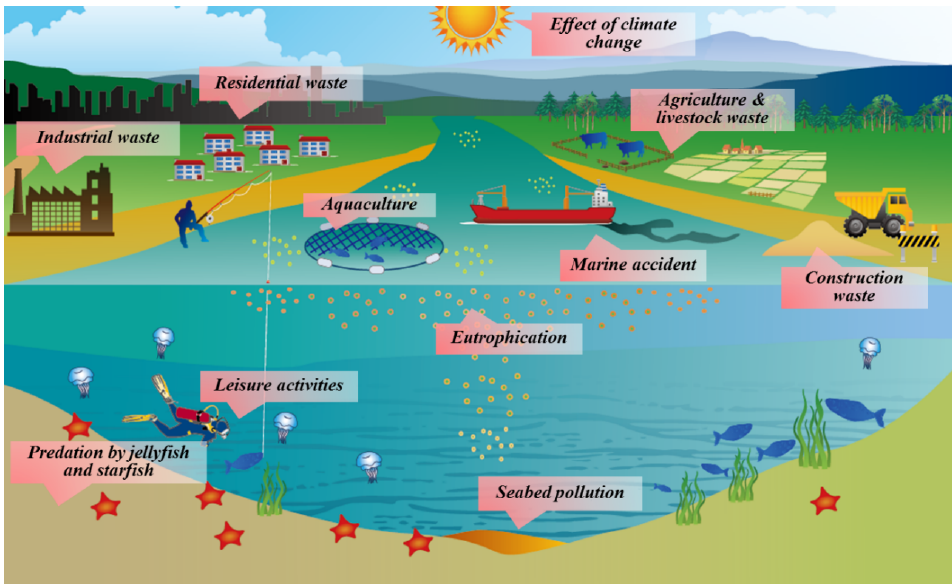
Figure A2. The ecological impacts of other driving forces on fishery resources and their ecosystem.